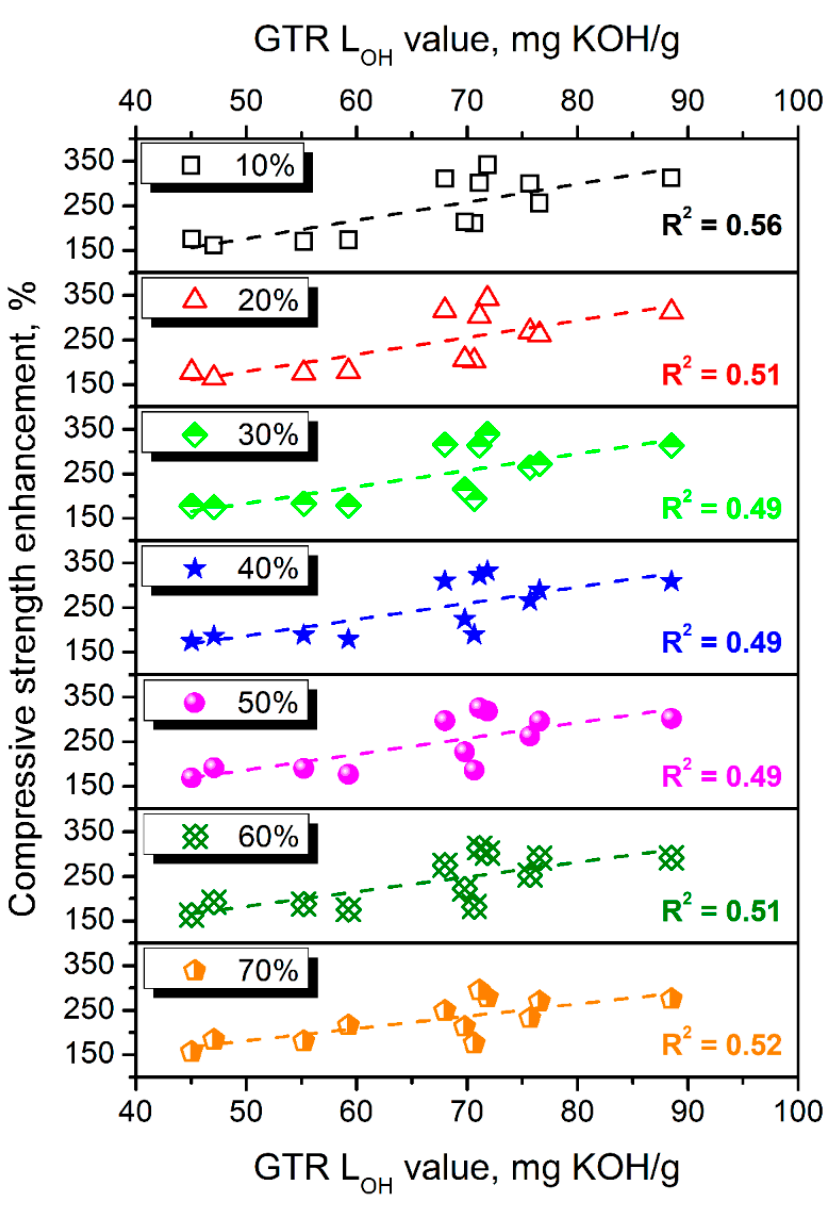
Figure 5. The enhancement of compressive strength at a different level of composites’ deformation resulting from applied formulation adjustments.